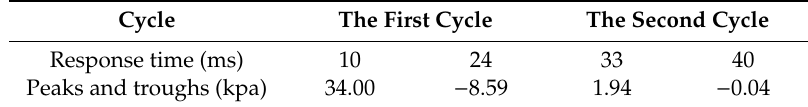
Table 4. The peaks and troughs of pore water pressure response curve in two cycles at 20 km / h. Cycle The First Cycle The Second Cycle